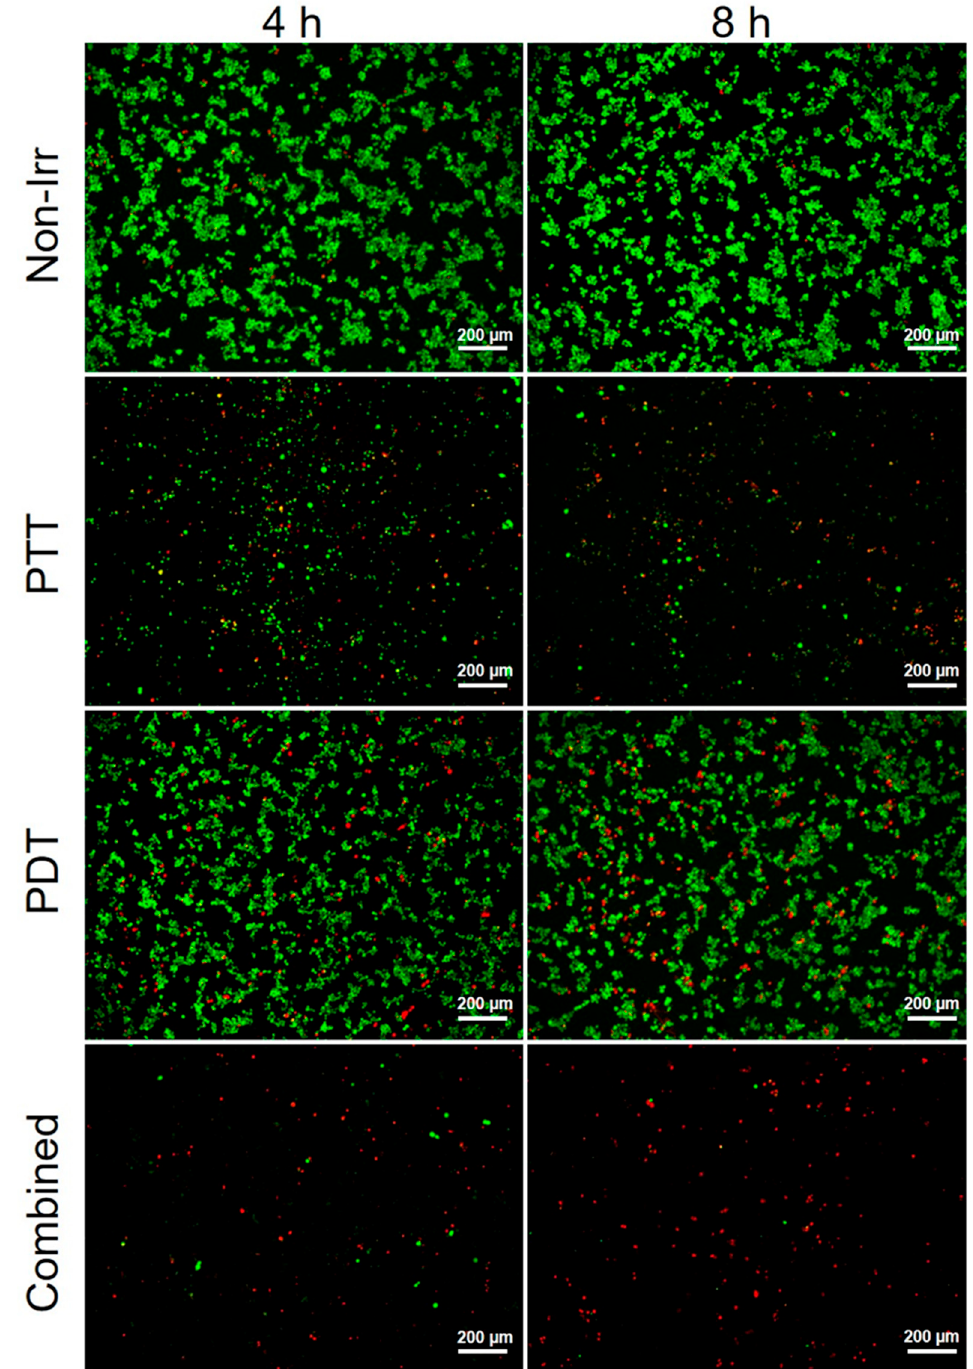
Figure 10. Fluorescence images of calcein AM (green signal from live cells, E x 495 nm and E m